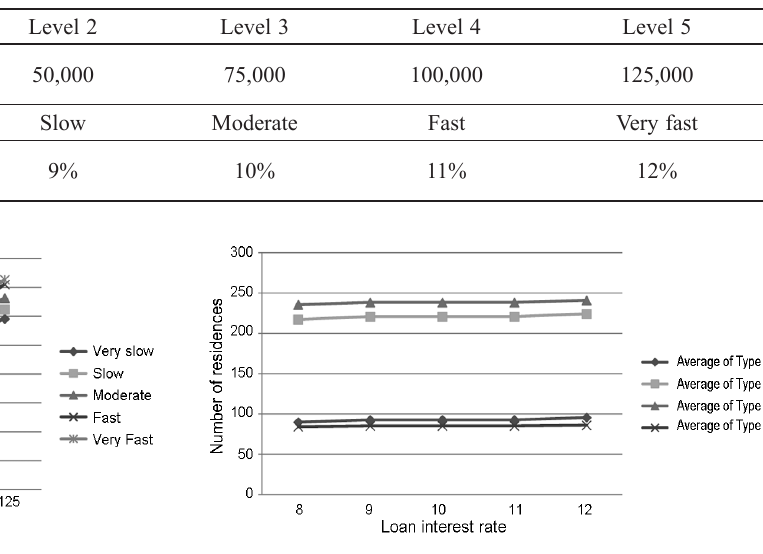
Fig. 2. NPV of the investment project depending on C and r